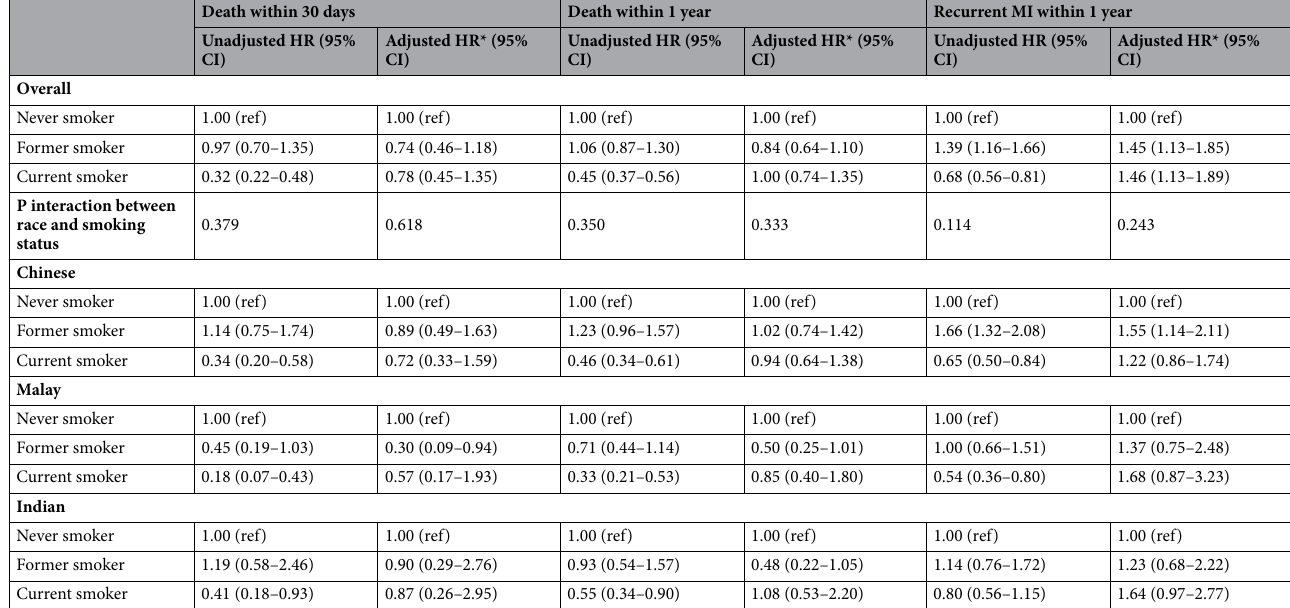
Table 4. Risk of death within 30 days, death within 1 year and recurrent MI within 1 year among former and current smokers compared to never smokers in NSTEMI patients. *Adjusted for race, age, gender, history of diabetes, history of hypertension, history of hyperlipidemia, history of AMI/CABG/PCI, body mass index, Killip class on admission, CPR in ambulance/ED, serum creatinine on admission, haemoglobin on admission, inpatient left ventricular ejection fraction. ** AMI acute myocardial infarction, CABG coronary artery bypass surgery, CPR cardiopulmonary resuscitation, ED emergency department, MI myocardial infarction, NSTEMI non ST-elevation myocardial infarction, PCI percutaneous coronary